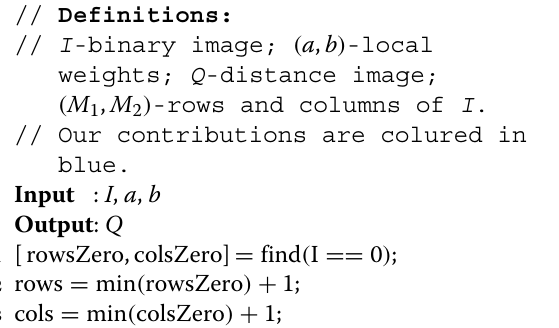
Algorithm 2: Fast chamfer algorithm.